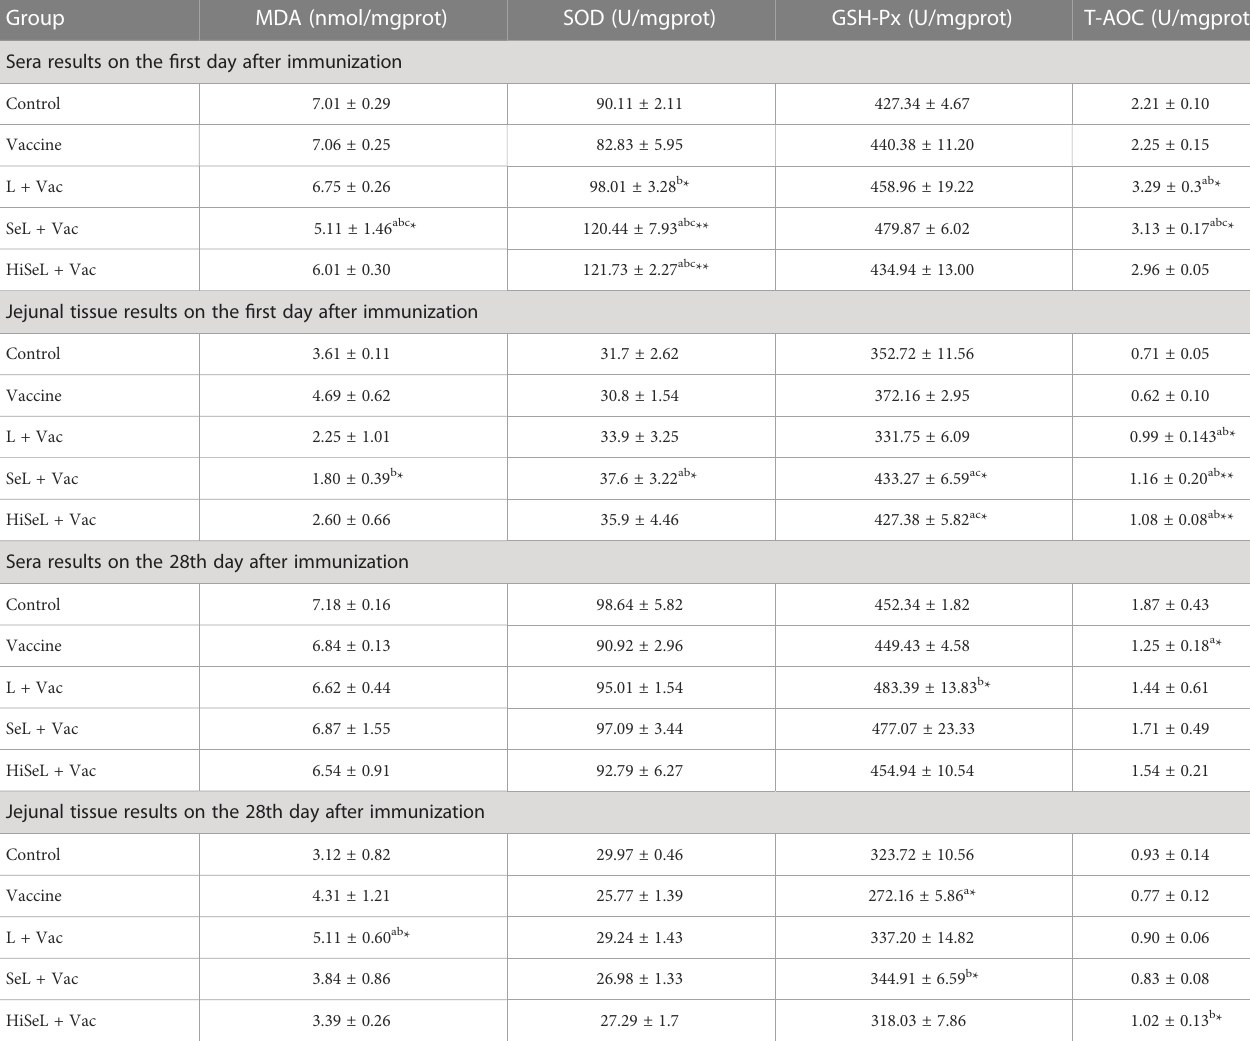
TABLE 1 Antioxidant indices in sera and jejunal tissue results on the fi rst and 28th days after immunization.